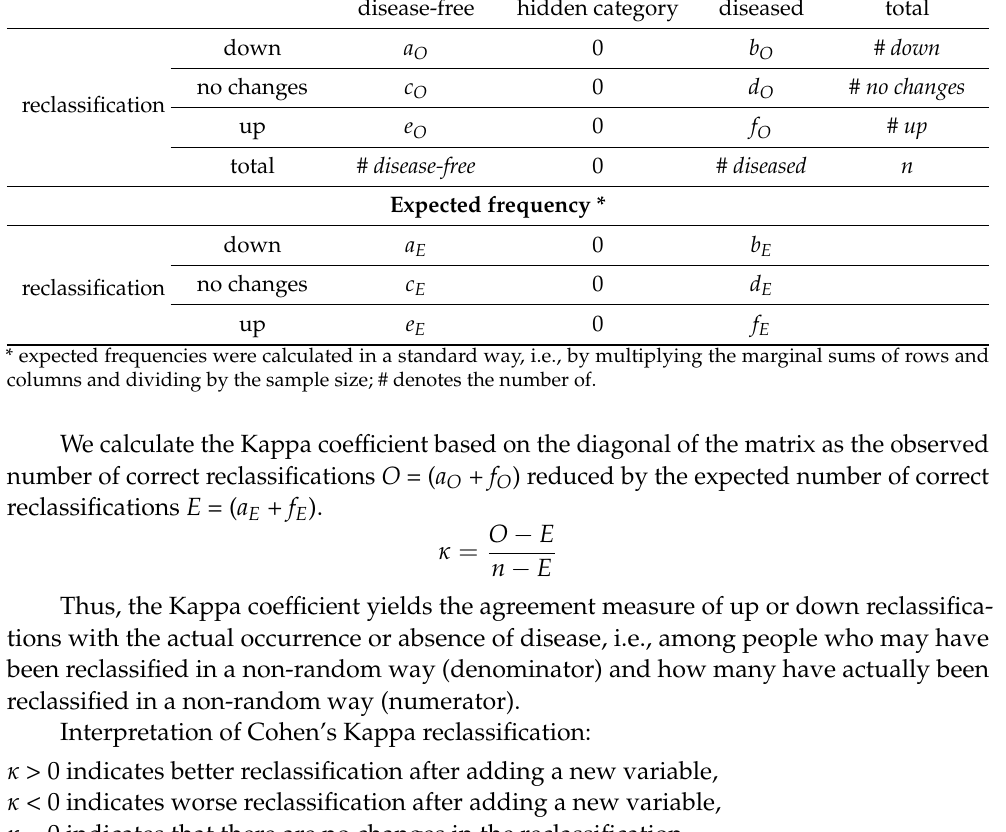
Table 2. Location of the hidden category in the table with observed reclassification to the group of people who were diagnosed with the disease and the group of disease-free individuals, and table with expected numbers for a random reclassification. Observed Frequency disease-free hidden category diseased total down a O 0 b O # down no changes c O 0 d O # no changes reclassification up e O 0 f O # up total # disease-free 0 # diseased n Expected frequency * down a E 0 b E c E 0 d E reclassification e E